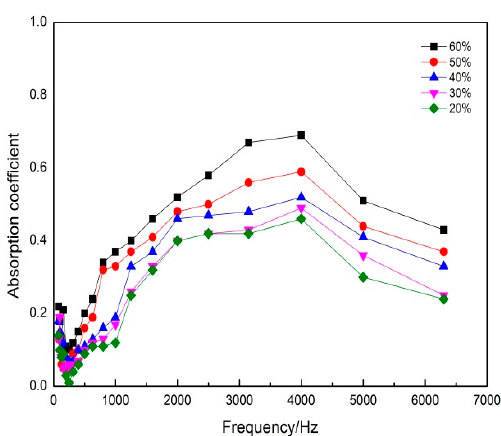
Figure 4. E ff ect of the mass fraction of DFs on sound absorption coe ffi cient. Figure 4. Effect of the mass fraction of DFs on sound absorption coefficient. Table 1. Maximum sound absorption coe ffi cient and average sound absorption coe ffi cient of the DFs Table 1. Maximum sound absorption coefficient and average sound absorption coefficient of the composites with di ff erent mass fraction. DFs composites with different mass fraction. Maximum Sound Mass Fraction of DFs (%) Mass fraction of DFs (%)